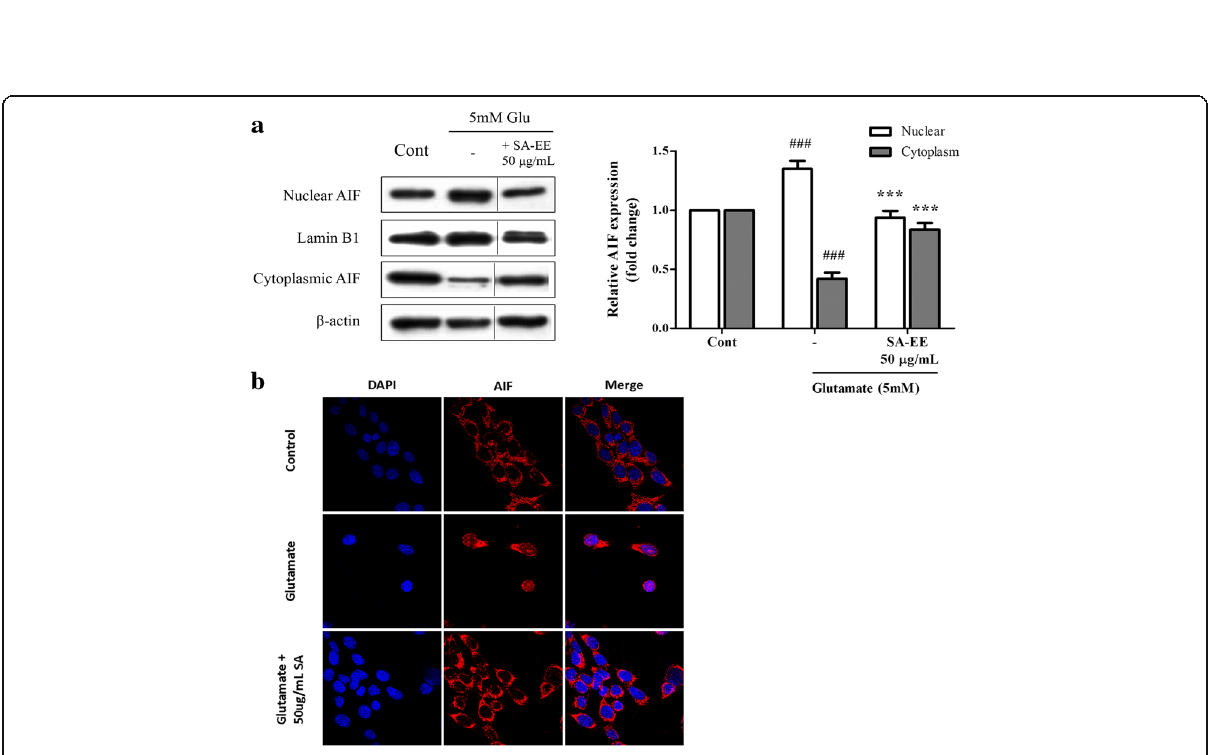
Fig. 5 Protective effect of SA-EE against glutamate-induced AIF nuclear translocation in HT22 cells. HT22 cells were exposed to 5 mM glutamate alone or glutamate in combination with 50 μ g/mL SA-EE for 16 h prior to western blot analysis of nuclear and cytoplasmic AIF levels ( a ). Lamin B1 and β -actin served as endogenous loading controls for nuclear extracts and whole cell/cytoplasmic extracts, respectively. All data were normalized to endogenous control levels and are expressed as the mean±SEM of at least three independent experiments. ### P <0.001 vs. control; ***P <0.001 vs. glutamate alone. Representative images of the cells stained with antibody against AIF (red) were observed under confocal microscope during treatment. The cells were counterstained with DAPI (blue) to indicate nuclear location ( b